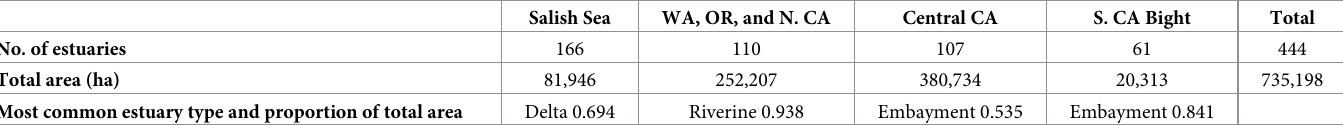
Table 4. Summary of estuaries identified in four ecoregions of the Central Pacific Coast of the United States. Total area is current plus historical estuary extent as defined by EBEEM mapping, and most common estuary types are abbreviations of CMECS terms: major river delta, riverine estuary, and